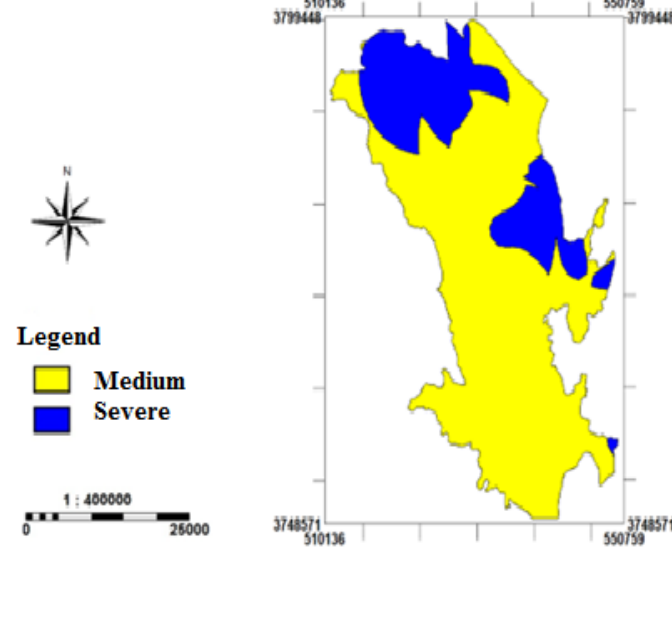
Figure 3. The map of desertification status based on water criterion